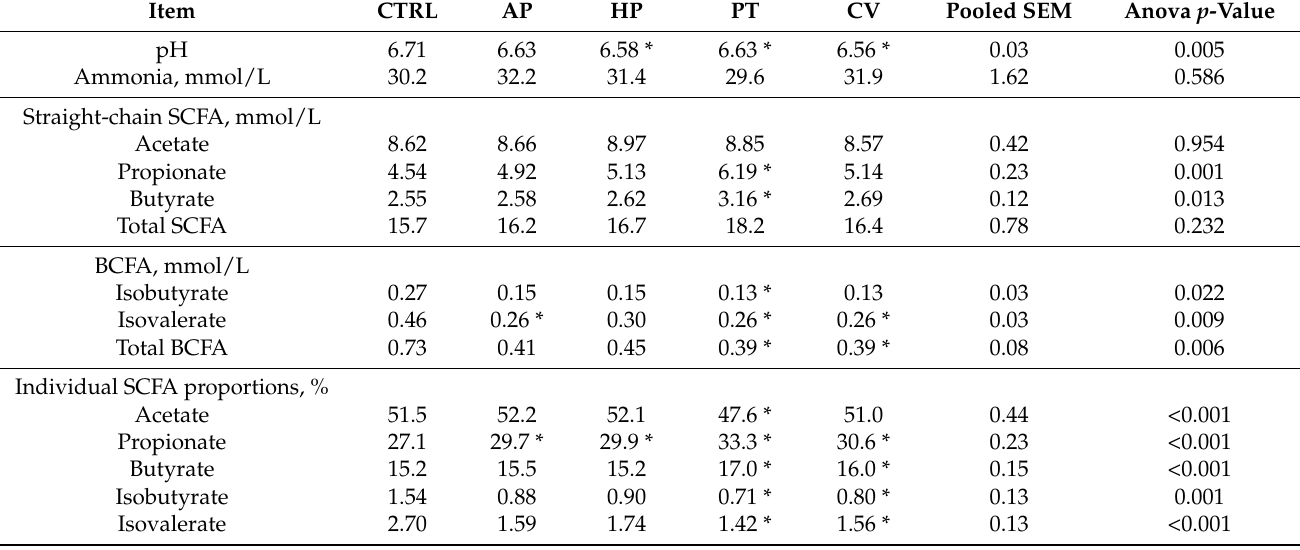
Table 4. pH values, ammonia and short-chain fatty acids concentrations after 6 h of an in vitro incubation of canine fecal inoculum supplemented with microalgae 1 .